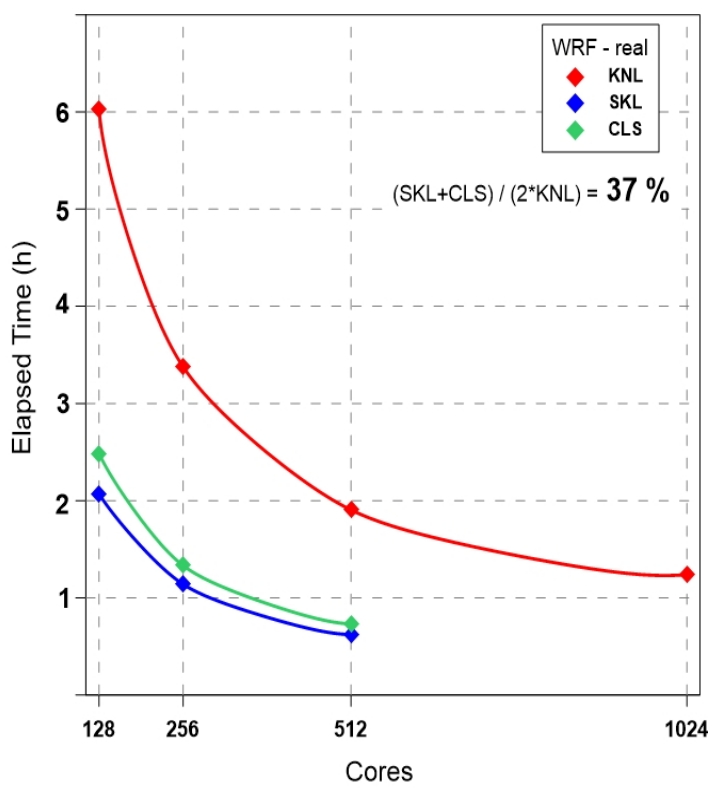
Figure 7. Performances of WRF-NWP by the number of cores for the real experiment: (SKL + CLS) / (2*KNL) = 37%.